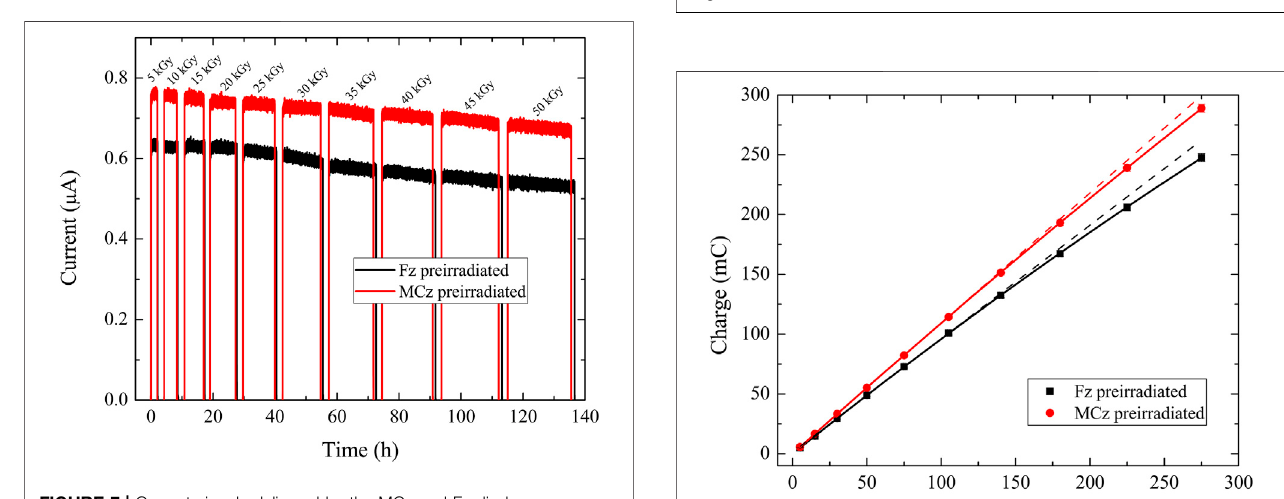
FIGURE 8 | Dose-response curves of the Fz and MCz diodes preirradiatedto700 kGycoveringthedoserangeof50 kGy.Thebest fi ttothe data is achieved with a second-order polynomial function. For comparison, the dashed lines show the departure from linearity in the high-dose region.